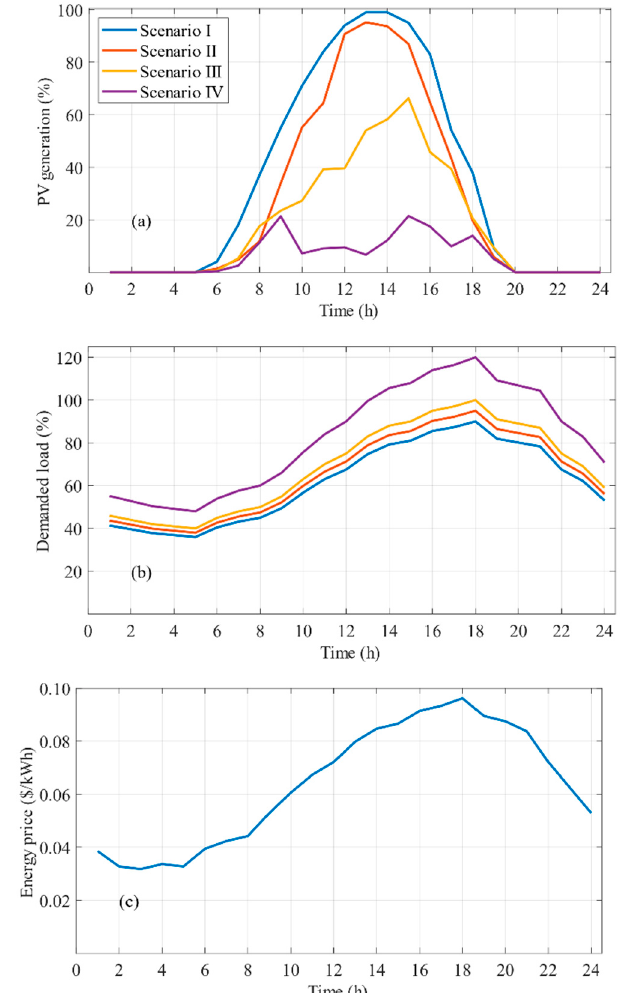
Figure 4. ( a ) Generation factor of PV DGs, ( b ) load for each stochastic scenario, and ( c ) energy cost.